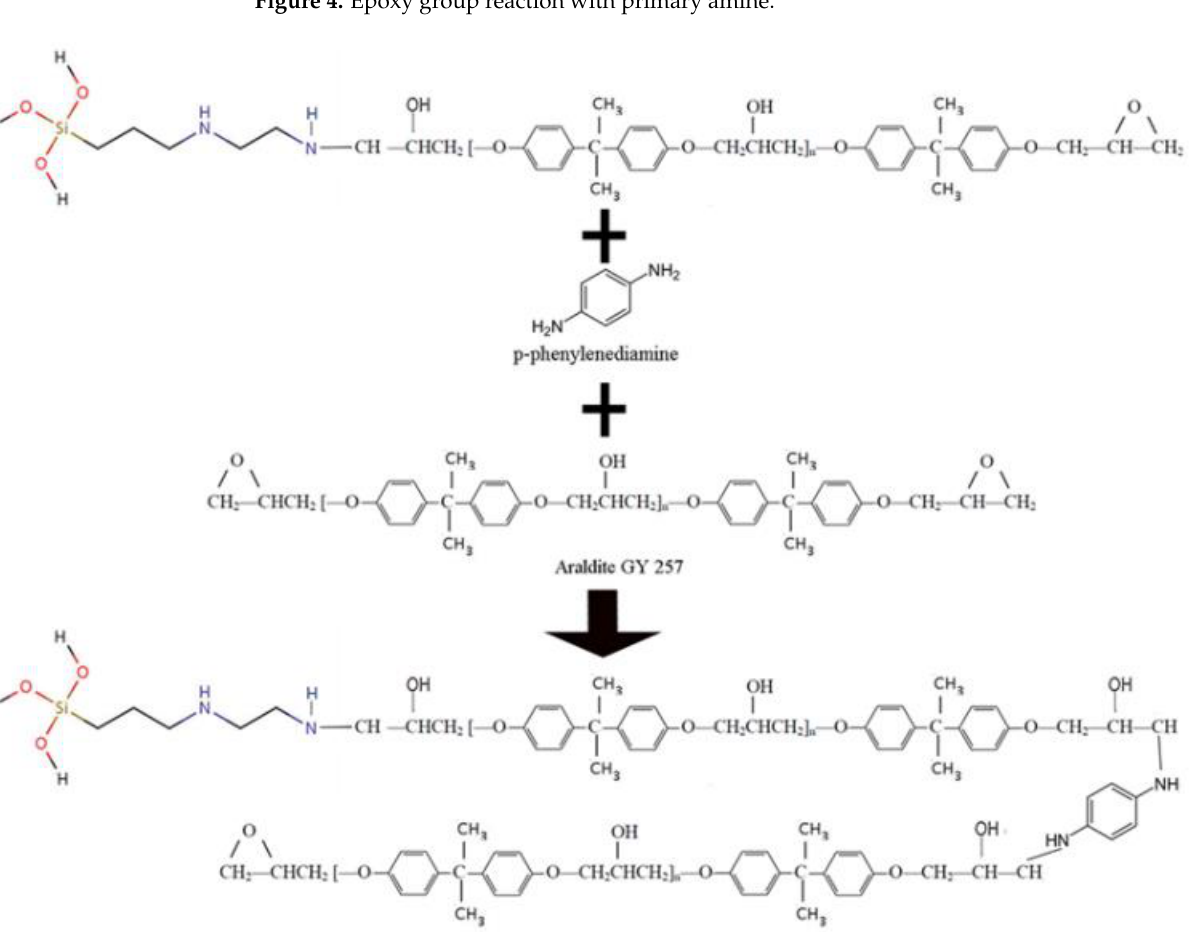
Figure 4. Epoxy group reaction with primary amine.